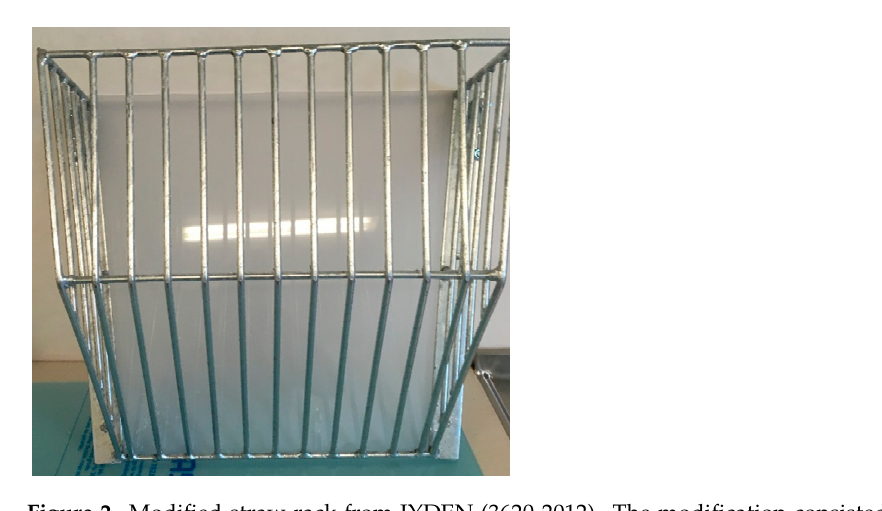
Table 2. Scoring system used to assess tail length (L0–L2) and tail damage (D0–D4) [21] Score 0